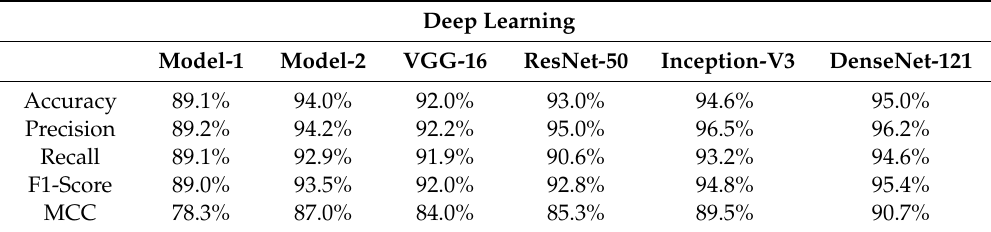
Table 6. Comparative analysis of non-handcrafted and handcrafted features classification. Metrics are for the test dataset.